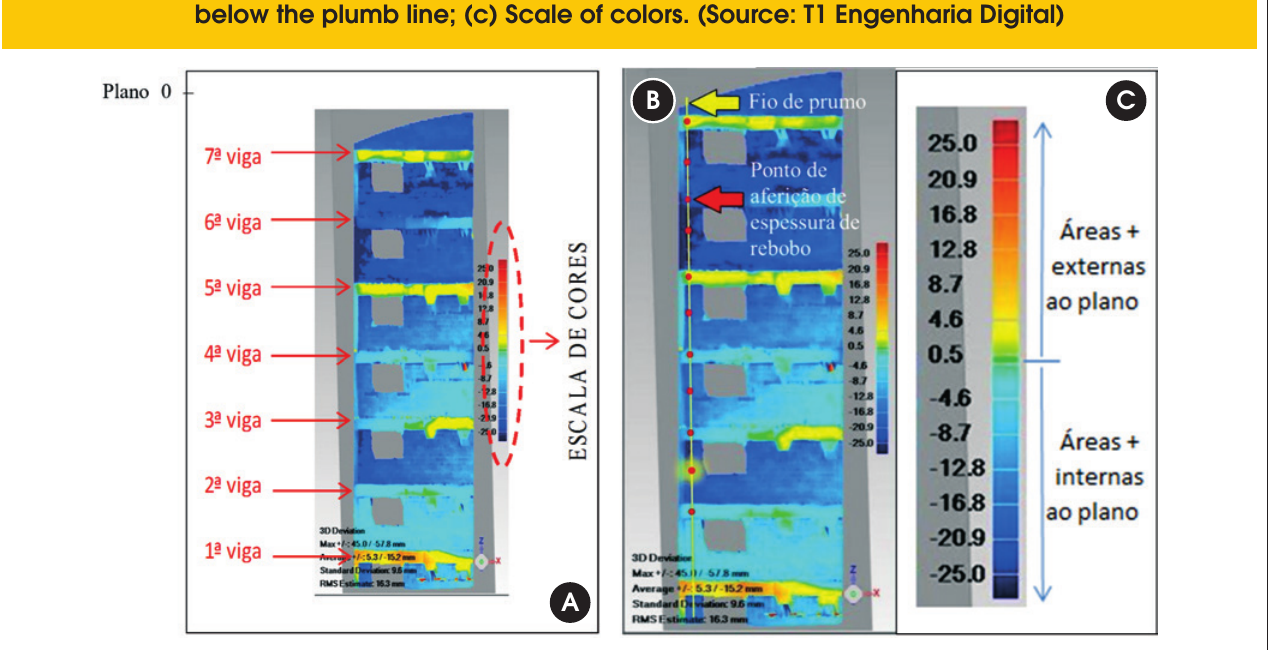
Figure 12 – (a) Image of the first reference plane generated by the software and identification of beams; (b) Critical irregularity points over 100% of the area of the scanned facade vs. points